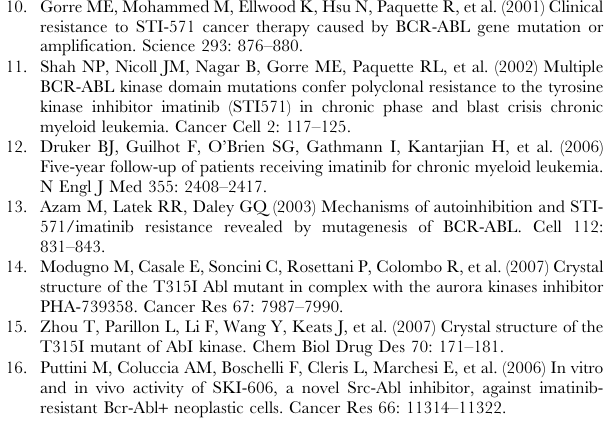
Figure S2 GNF-5 binds to the myristic pocket and inhibits activity in Bcr-Abl T315I. A . Dasatinib antiproliferative EC50 in the presence of 0.4 to 10 m M GNF-5 on Ba/F3 cells expressing T315I and E505K Bcr-Abl. B . Inhibition of Bcr-Abl autopho- sphoryl-ation was determined by Bcr-Abl immunoprecipitation, followed by a immunoblot for phospho-Tyr (Tyr412) [4], phospho-STAT 5 (Tyr694) and total Bcr-Abl (antibody K-12) from cell lystates obtained after treatment of T315I Bcr-Abl expressing Ba/F3 with 10 m M of dasatinib and increasing Figure S3 Comparison of deuterium exchange in wild-type Abl and T315I. The deuterium uptake curves for six representative peptides are shown in the left [solid lines: wild-type Abl; dotted lines: T315I]. All other deuterium uptake curves for all other regions showed no significance difference between wild-type and T315I and are therefore not shown. The location of each peptide, according to the labels A-H, is shown on the crystal structure at the right (PDB 1OPL). Coloring is as in Figure 3: obvious changes (colored hot pink) were defined as a difference between deuterium exchange-in curves of 1.0 Da or more. Subtle changes (colored light yellow) were 0.4-1.0 Da. No changes were differences of 0.0- 0.4 Da. Residues corresponding to the hydrophobic spine M309, L320 and F401 are colored blue and rendered as sticks. The 1OPL crystal structure was chosen to display these data because we observed subtle changes in regions outside of the kinase domain, namely in the SH2 domain residues 137-157. Abl kinase is